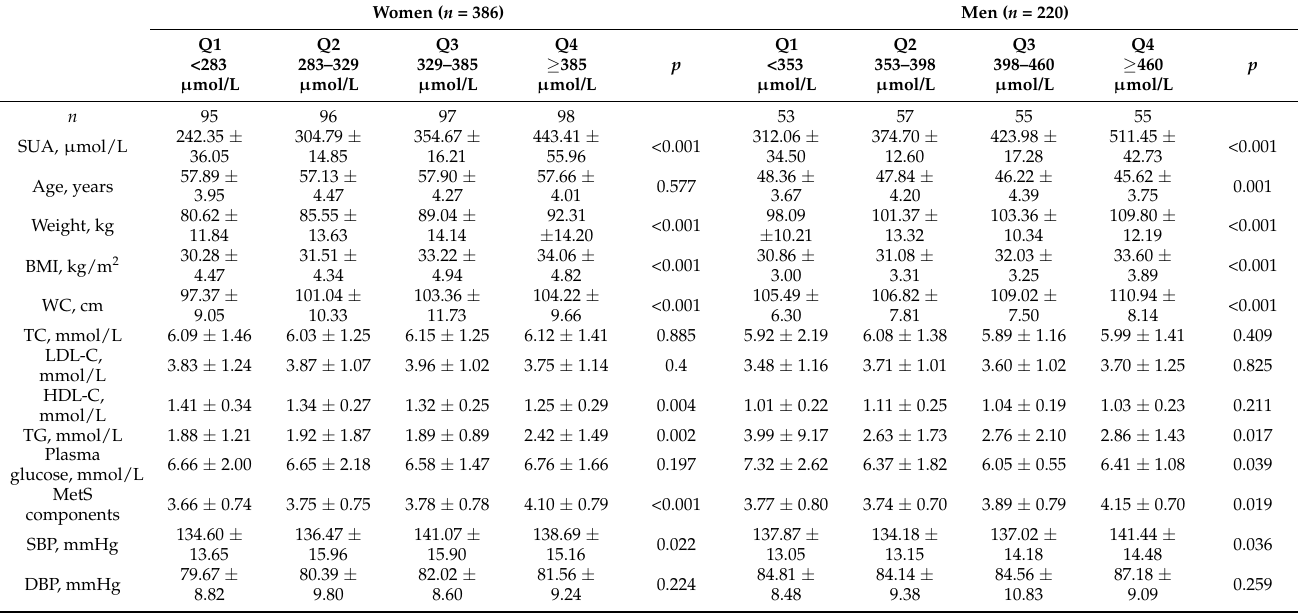
Table 1. Clinical characteristics of participants in quartiles of serum uric acid